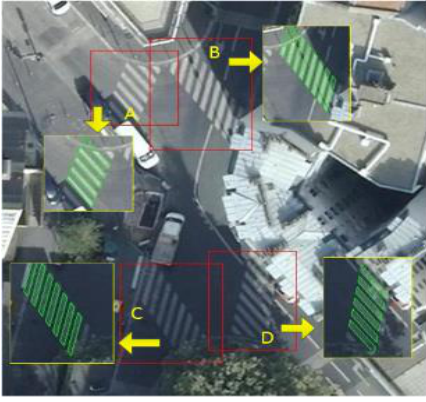
Figure 18. Reconstruction results of rhomboid zebra crossings.